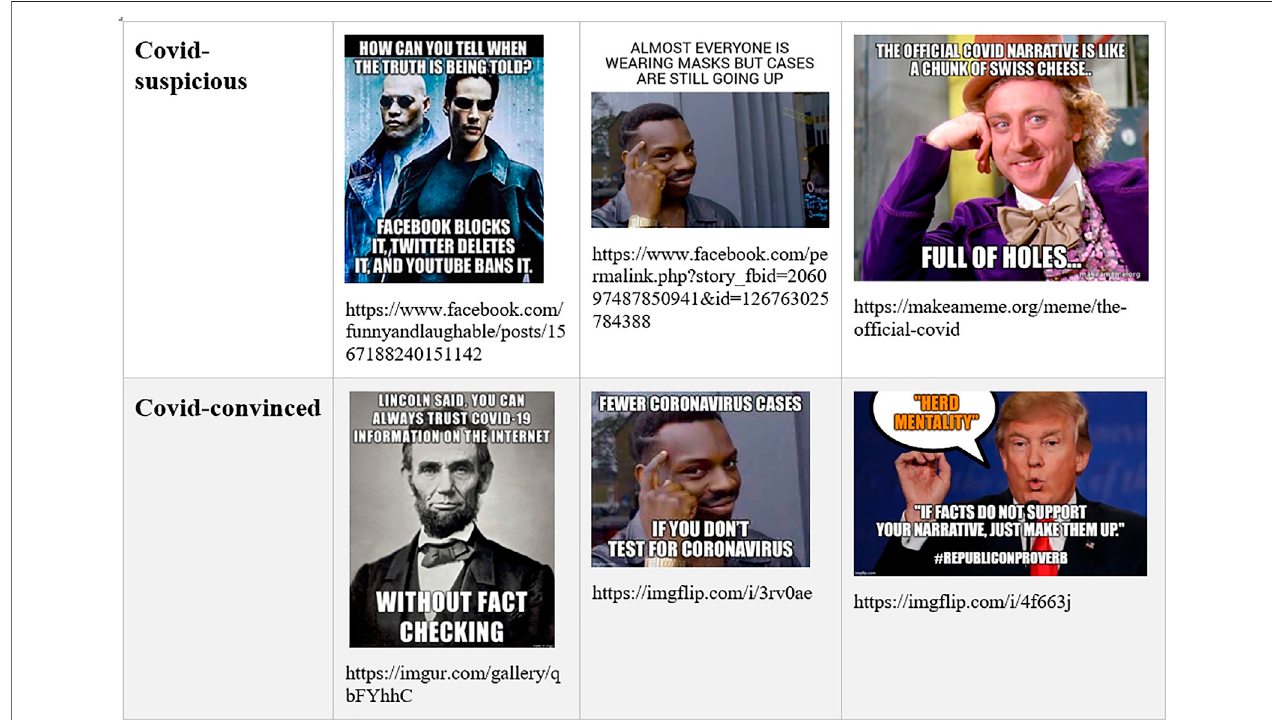
FIGURE 3 | Seeking for the factual truth in Covid-suspicious and Covid-convinced memes.